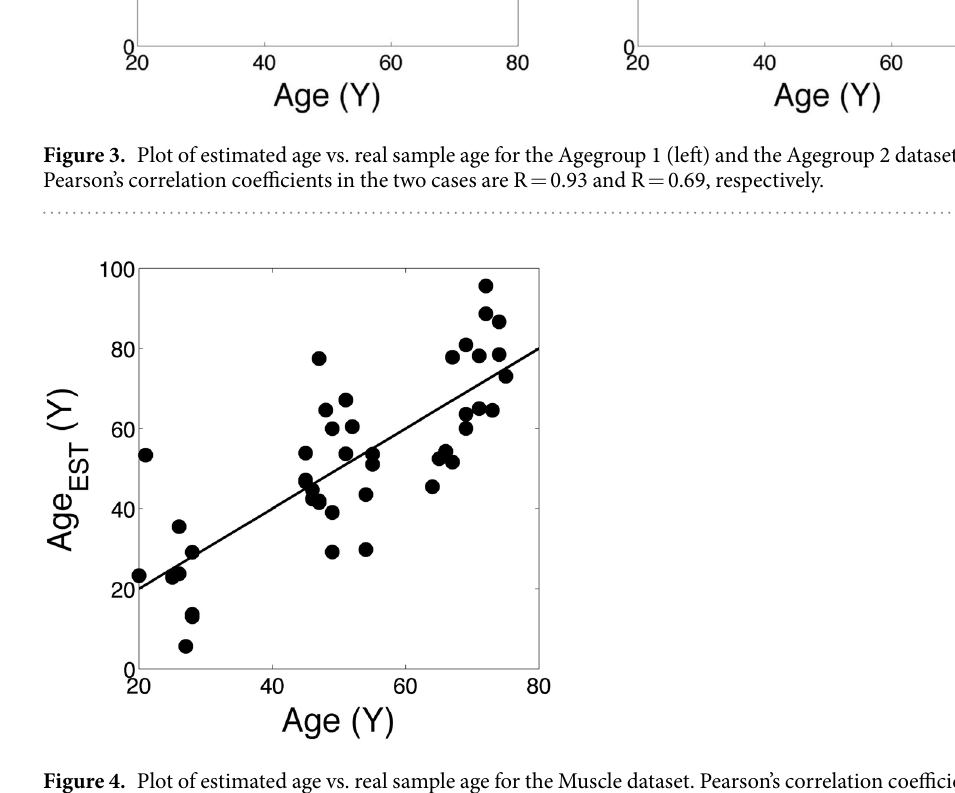
Figure 4. Plot of estimated age vs. real sample age for the Muscle dataset. Pearson’s correlation coefficient is R =